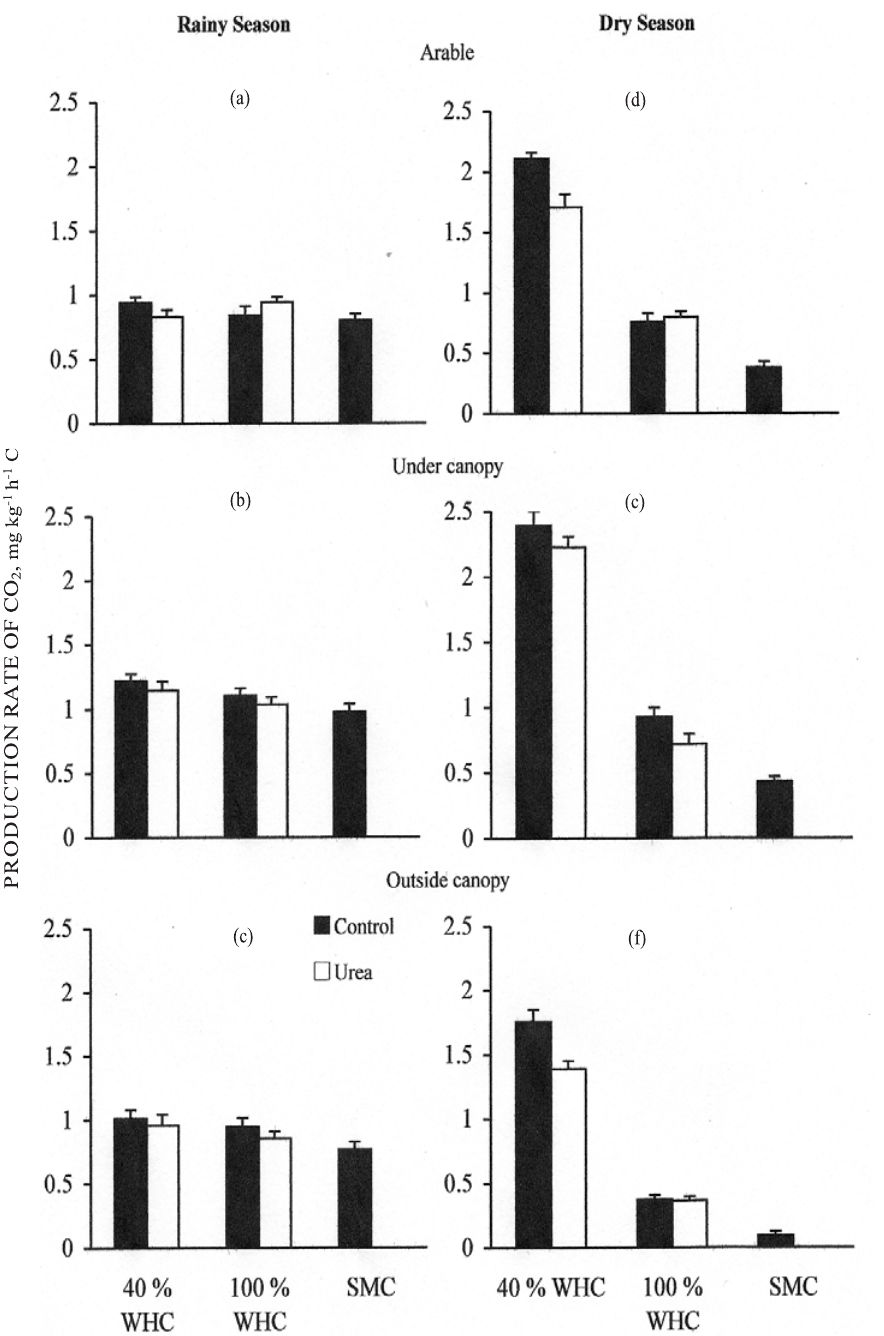
Figure 2. CO production rate from soil samples of arable land and of soil under canopy and outside the 2 canopy of Acacia angustissima in the rainy season and dry season amended or not with 12 mg kg -1 urea- N soil incubated at 40, 100 % water-holding capacity (WHC) and soil moisture content (SMC). Bars are standard error of the estimate (p <